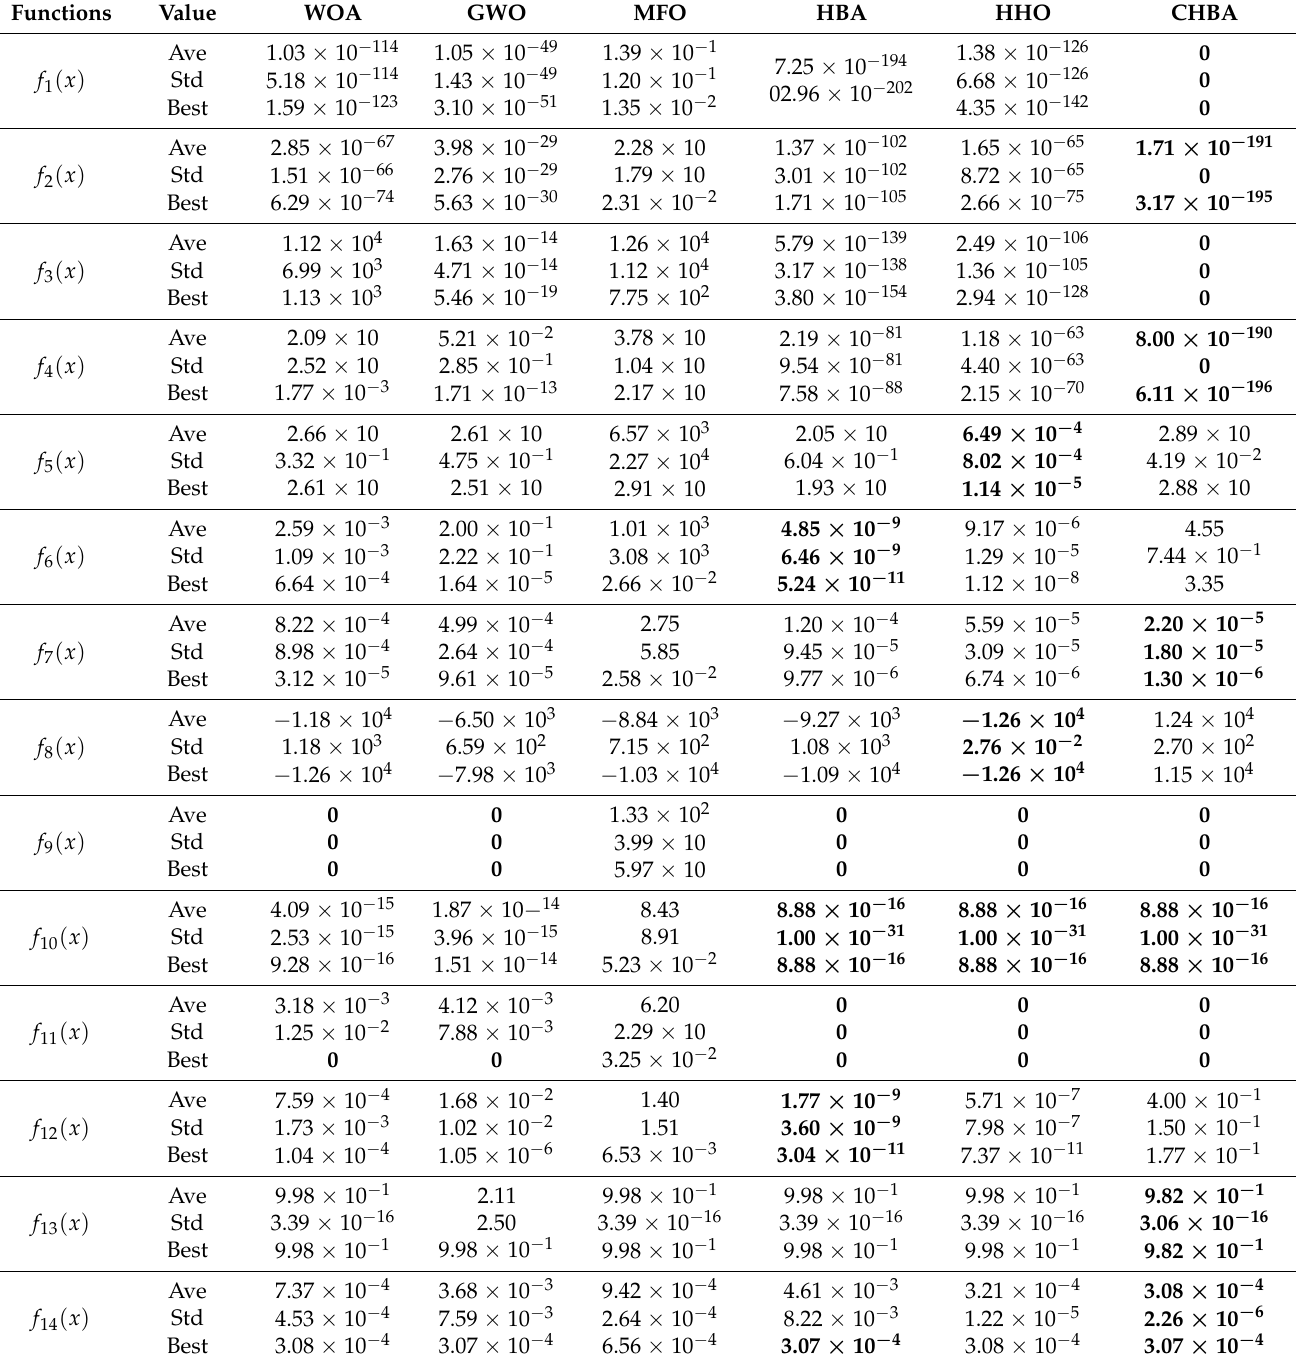
Table A1. Test Results of the Benchmark